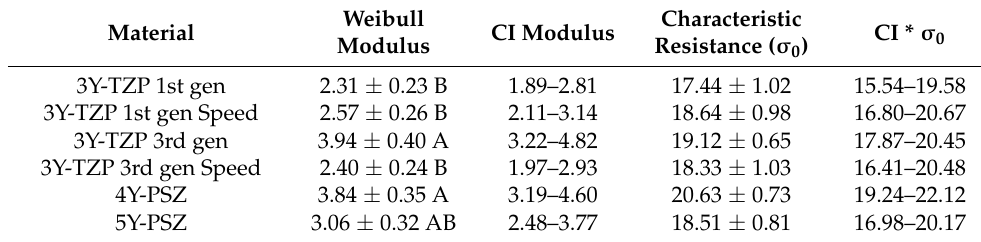
Table 4. Data from the Weibull analysis.